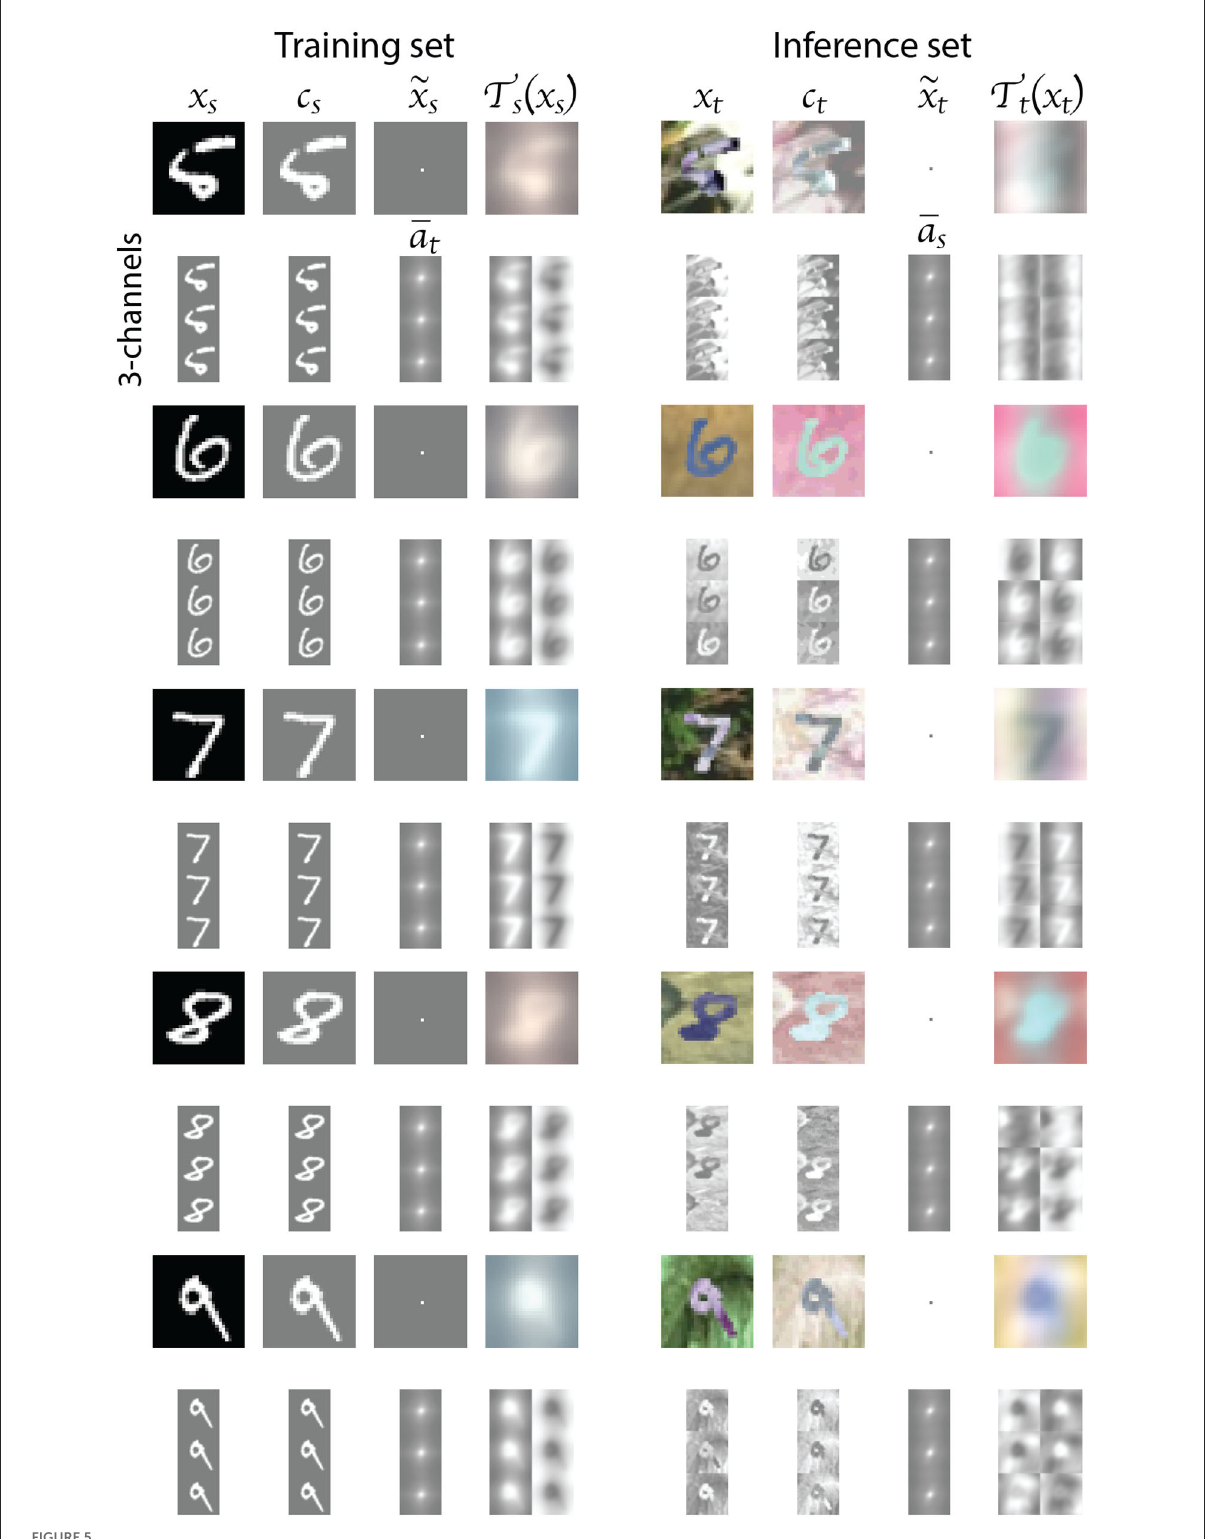
FIGURE5 The transformation results for examples from digits 5 to 9 images. The left column shows the transformation of source (MNIST) data, and the right column shows the transformation of the target (MNIST-M) data. For each input, we show the composite and the 3-channel transformation. The last column of the second row shows the 3-channel output and its polarity reversal, which we implement in the augmentation of the training